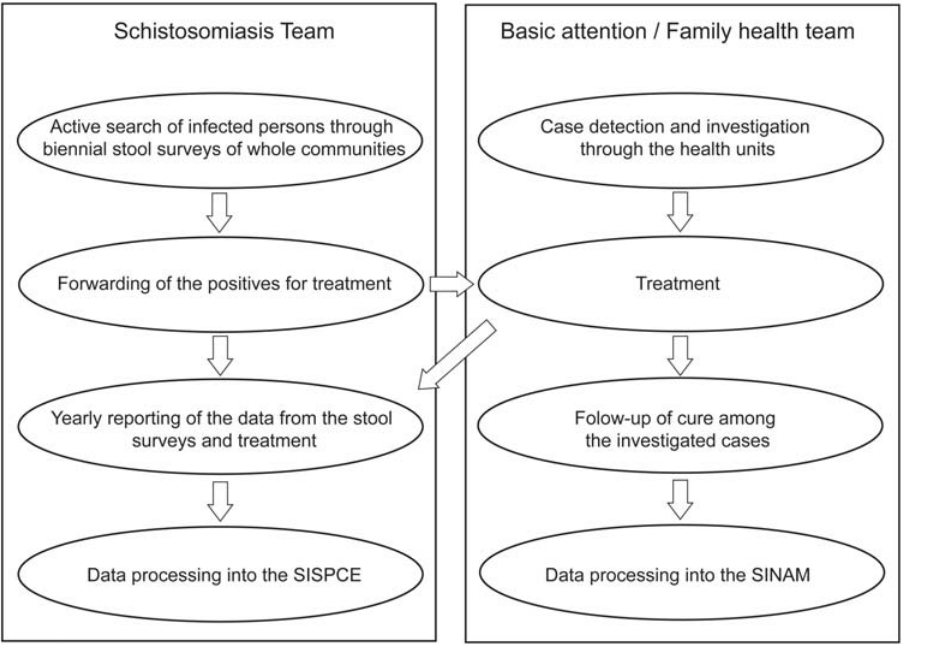
Figure 1. Schistosomiasis Control Program. Flowchart of the activities of the Schistosomiasis Control Program within the Unified Health System (PCE-SUS) at the municipal